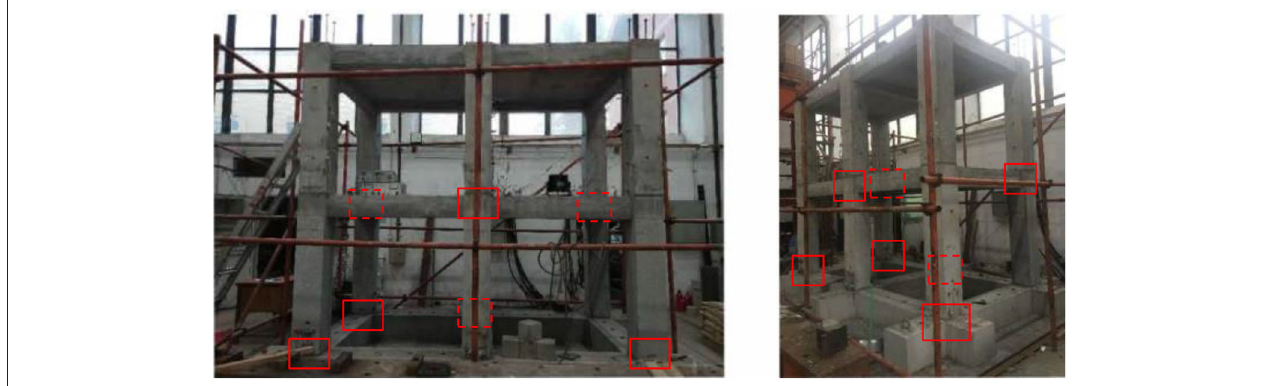
FIGURE 8 | Frame structure model after assembly. Red rectangles represent locations of defects (the dashed lines indicate that they are shaded).